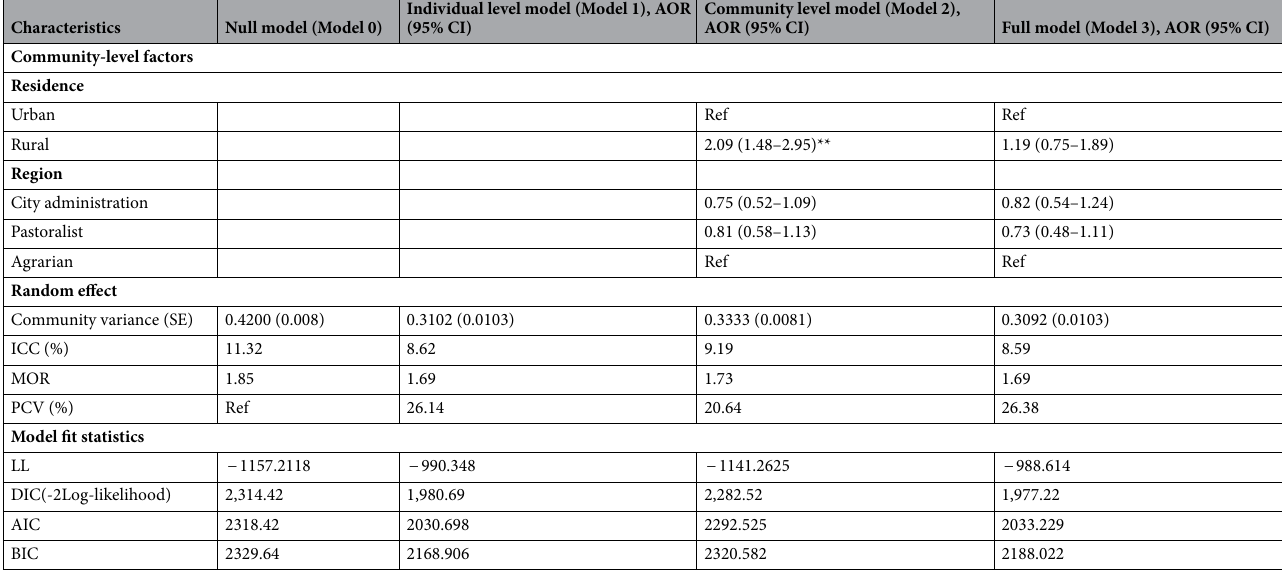
Table 3. Multivariable multilevel logistic regression analysis of factors associated with childhood stunting among children aged 0–23 months in Ethiopia, EMDHS 2019. ** p -value < 0.001; * p -value < 0.05; SE Standard Error; ICC Intra-class Correlation Coefficient; MOR Median Odds Ratio; PCV Proportional Change in Variance; AIC Akaike’s Information Criterion; BIC Bayesian information Criteria; DIC Deviance Information Criterion; LL